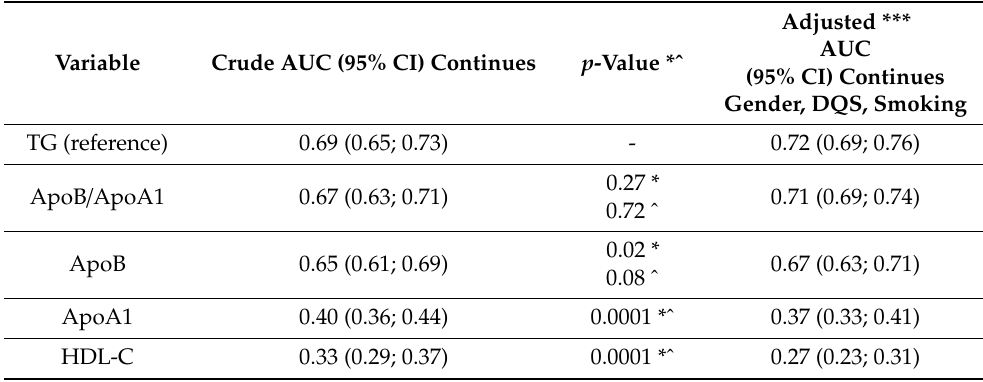
Table 5. Sensitivity and specificity of ApoB/ApoA1 ratio, TG, HDL-C, ApoB, and ApoA1 in the diagnosis of MS .